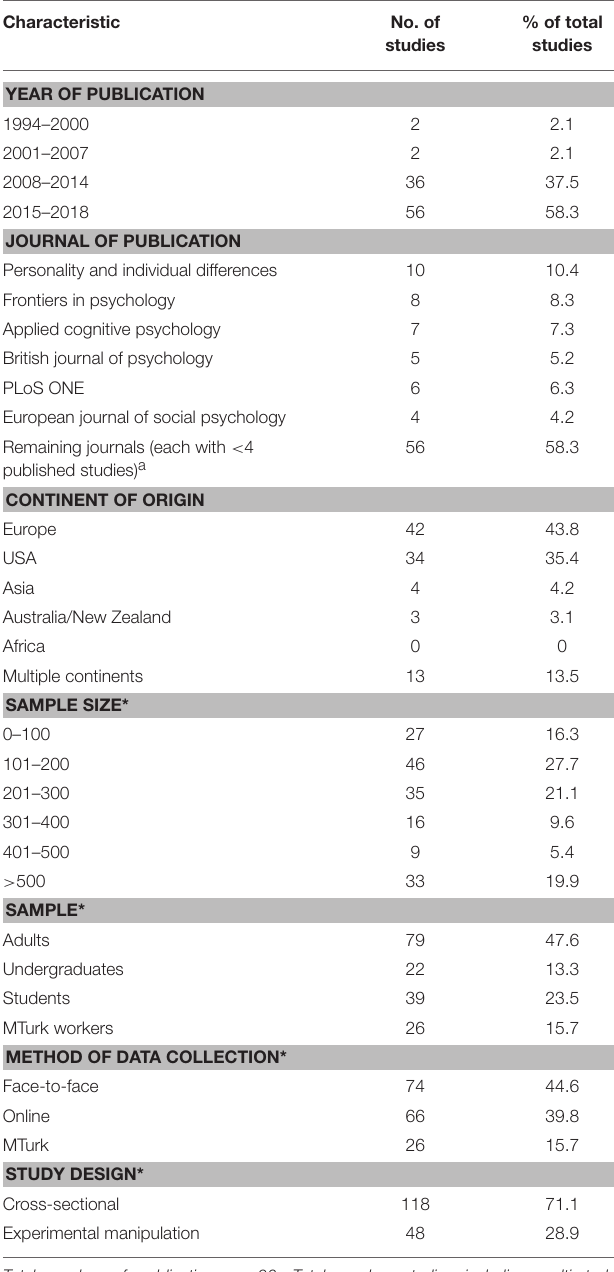
TABLE 1 | Characteristics of the 96 studies included in this